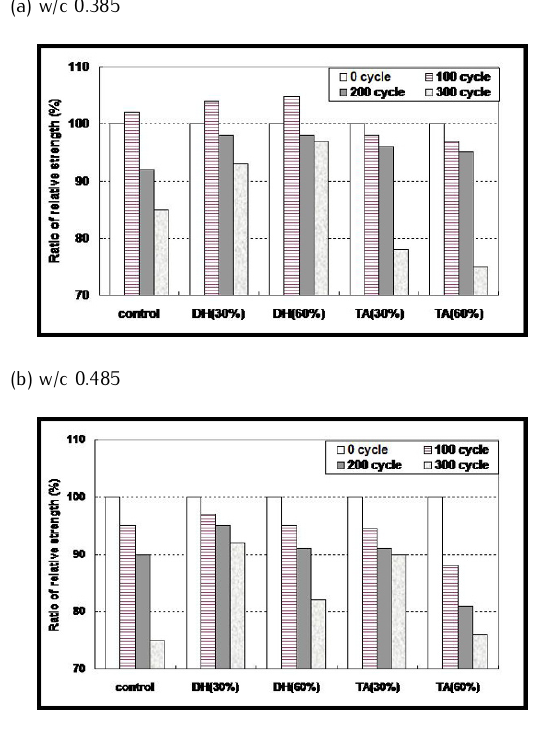
Figure 10. Relative strength ratio after freezing and thawing cycles (with HWRA).